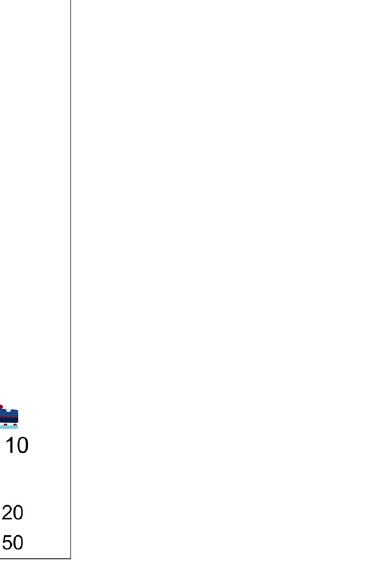
Fig 7. Net savings from one male circumcision, by discount rate (USD, adjusted for